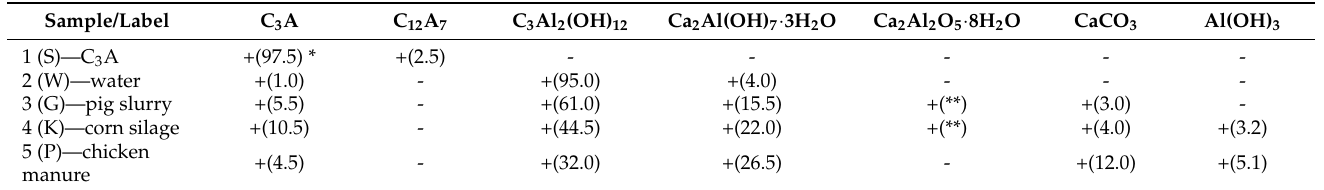
Table 1. Qualitative and quantitative composition of cement slurries from C 3 A hydrated in water or corrosive media, as